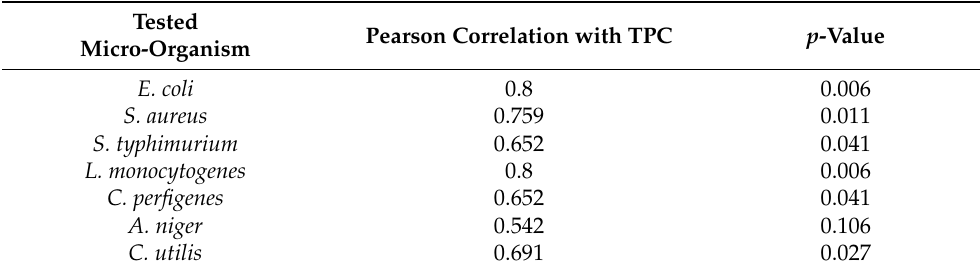
Table 5. Pearson correlation of Total phenol content of samples with the MIC of the tested microorganism. Tested